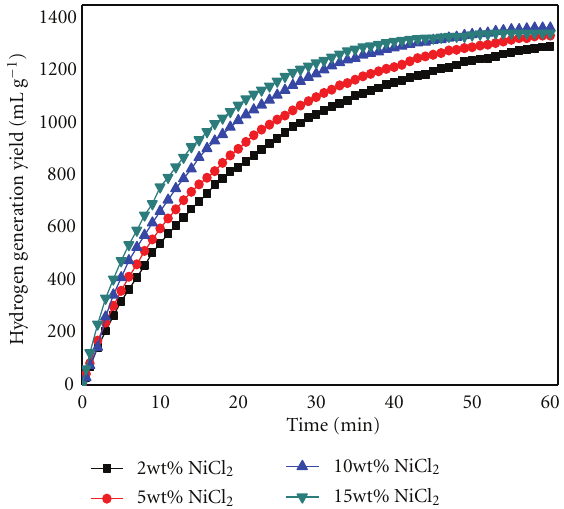
Figure 1: Hydrogen generation performance of Al-15wt. %La- x wt. %NiCl 2 /NaBH 4 mixture (weight ratio, 1 :1) at 323K. 10,